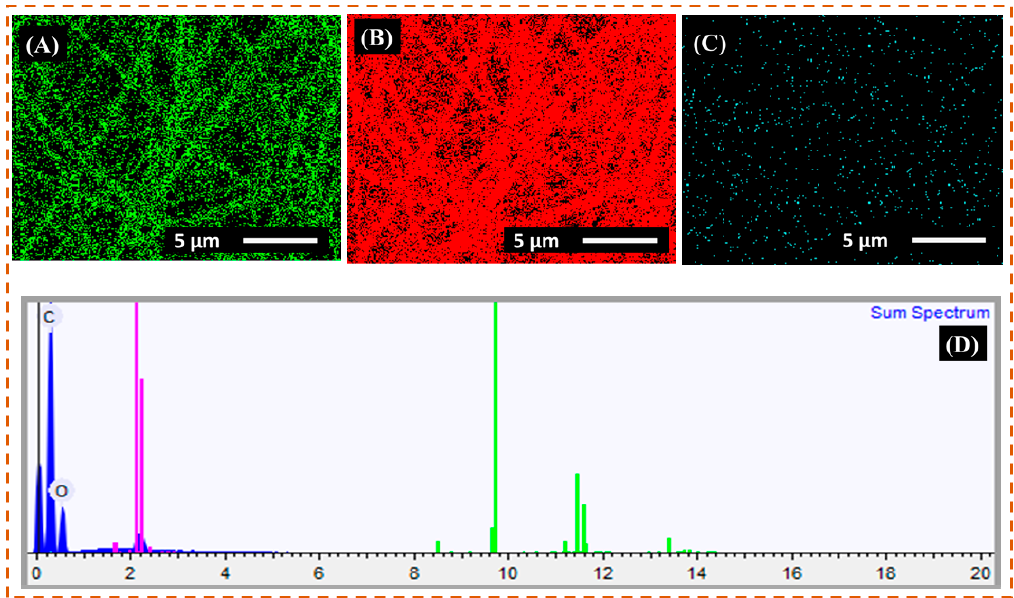
Figure 2. EDX elemental mapping and spectrum of neat r-PET nanofibers. ( A – C ) show the oxygen, carbon, and gold elemental mapping, respectively. ( D ) EDX full spectrum of neat r-PET nanofibers.